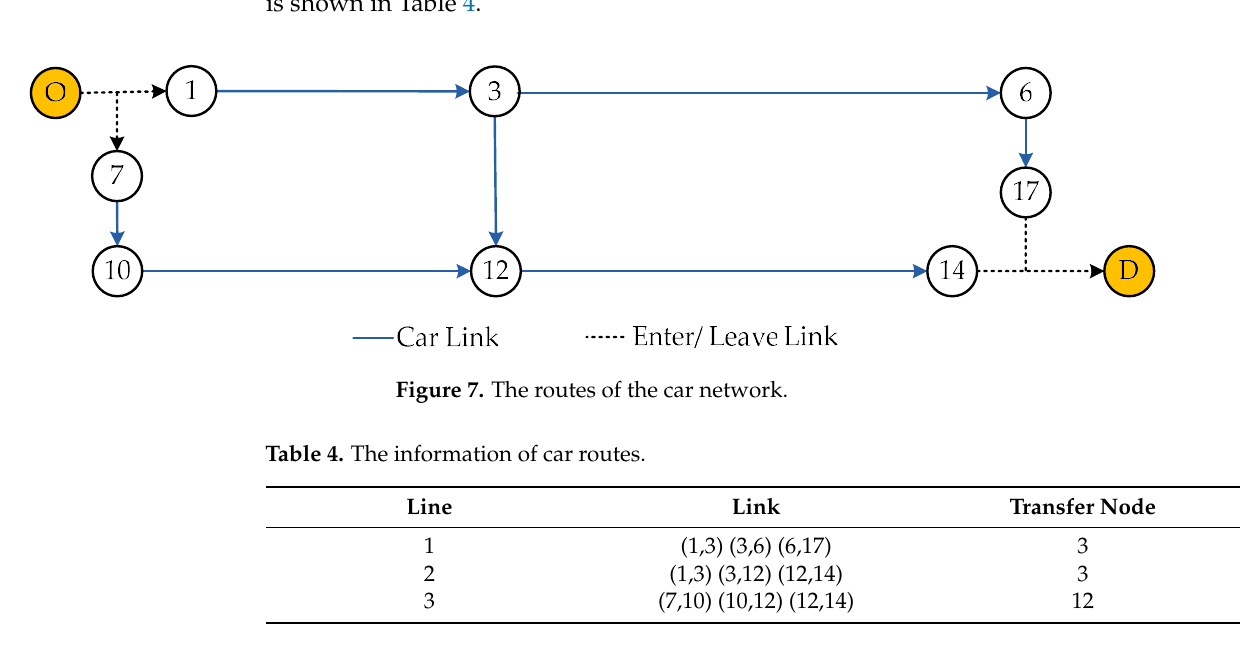
Figure 8. The car super network topology. In summary, by connecting the same nodes among different modes, a multimodal transportation super network topology (Figure 9) is obtained, of which three layers are bus, rail transit, and car network topology respectively. In Figure 9, the pink dotted links clearly illustrate the inter-modal transfers among bus, rail transit, and car, as well as the inter-route transfers of bus or rail transit.